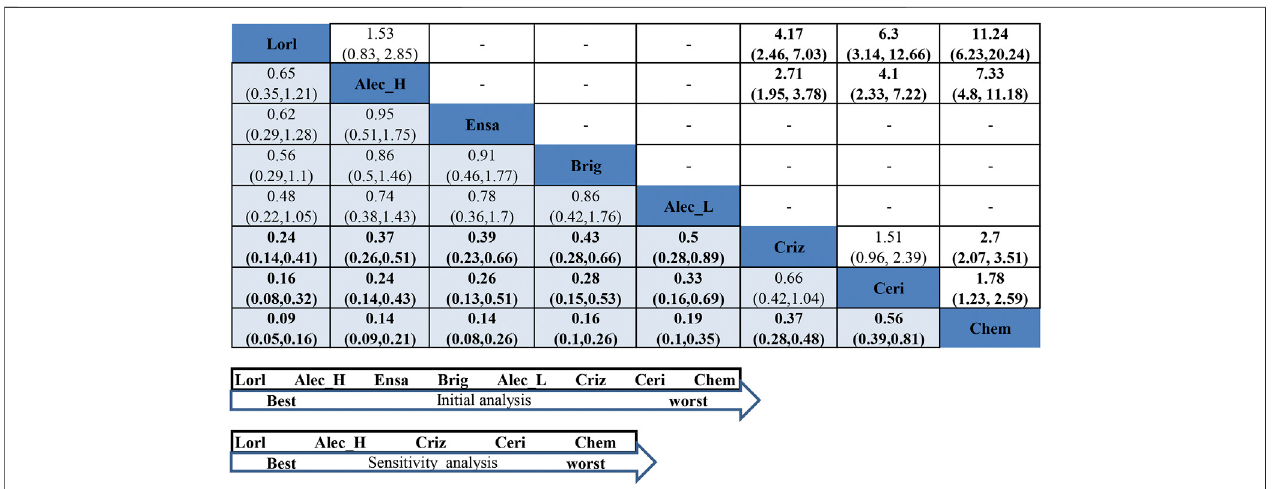
FIGURE5| NMAresultsofnever-smokeronprogression-freesurvival(lowerleft)andsensitivityanalysis(upperright),followedbytherankingdistributionaccording to SUCRA values (lower arrow shape). NMA, network meta-analysis; SUCRA, the surface under the cumulative ranking curve; Chem, chemotherapy; Criz, crizotinib; Ceri, ceritinib; Alec_L, low-dose alectinib; Alec_H, high-dose alectinib; Brig, brigatinib; Lorl, lorlatinib; Ensa, ensartinib. Values in bold mean statistically signi fi cant.